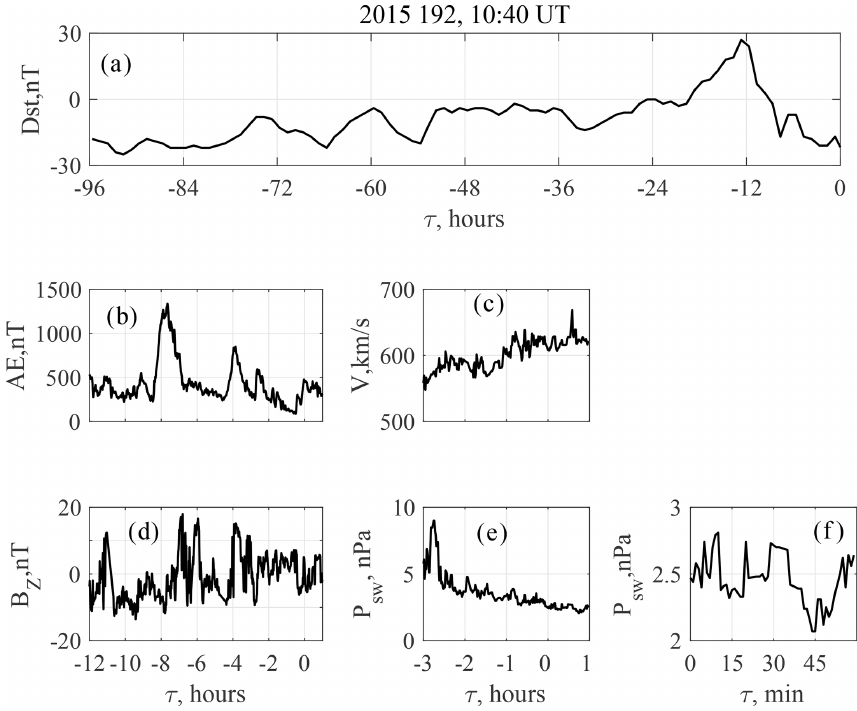
Figure 8. Space weather conditions for event 2. (a) Dst index during last 4d; (b) AE index during the interval and 12h before; (c) SW speed during the interval and 3h before; (d) IMF B Z during the interval and 12h before; (e) SW dynamic pressure during the interval and 3h before; (f) details of SW dynamic pressure fluctuations.